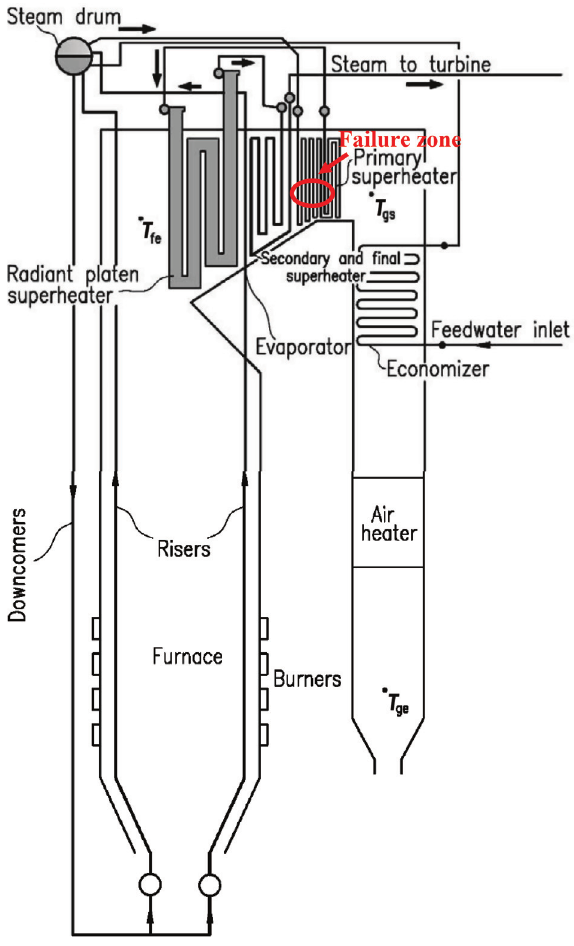
Figure 1: Location of failure region in thermal power plant boiler.